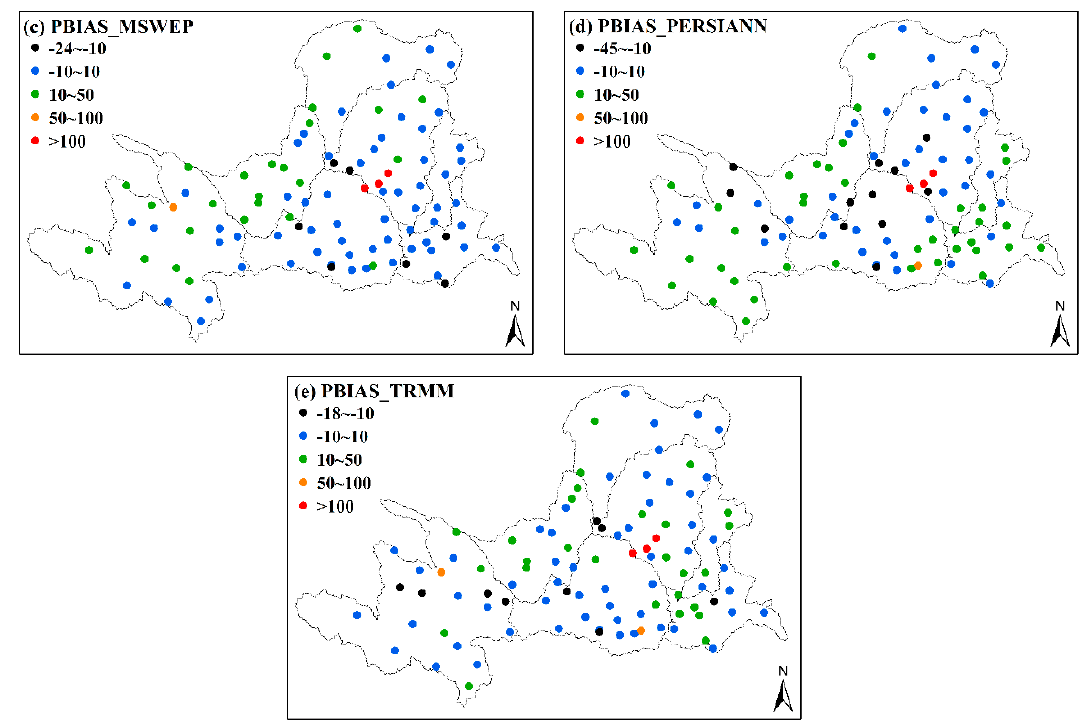
Figure 11. Spatial pattern of PBIAS (bias) on daily scale.